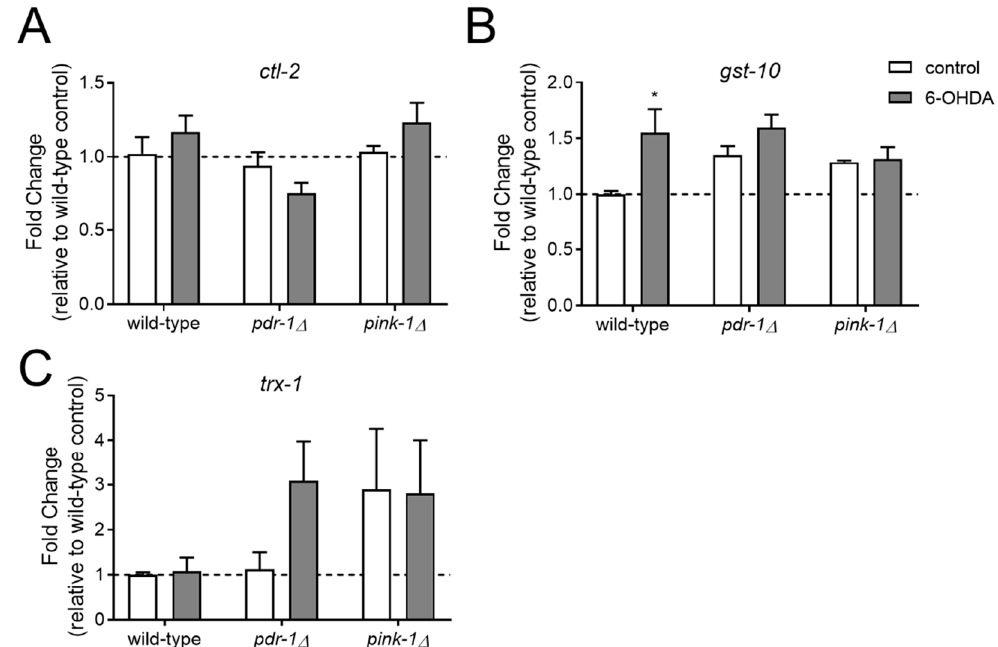
Figure 6. Antioxidant gene expression is not significantly altered in pink-1 and pdr-1 mutants.